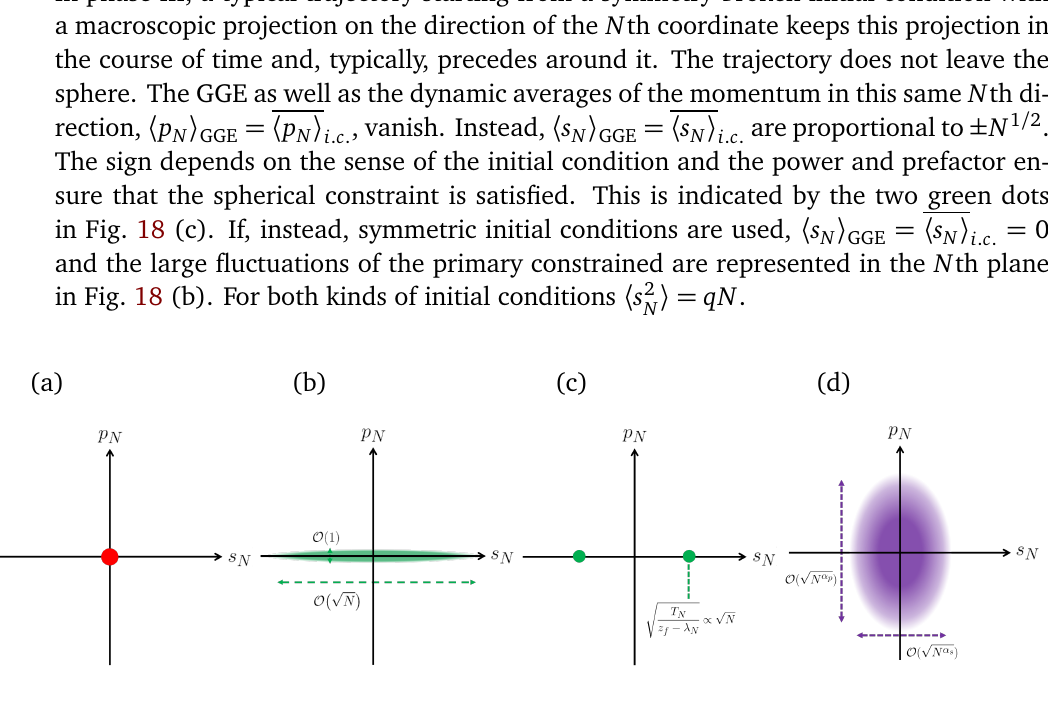
Figure 18: Sketches of the s follows the one of the four phases. (a) Phases I and II. (b) Phases III with symmetric initial conditions. (c) Phases III with symmetry broken initial conditions. (d) Phase